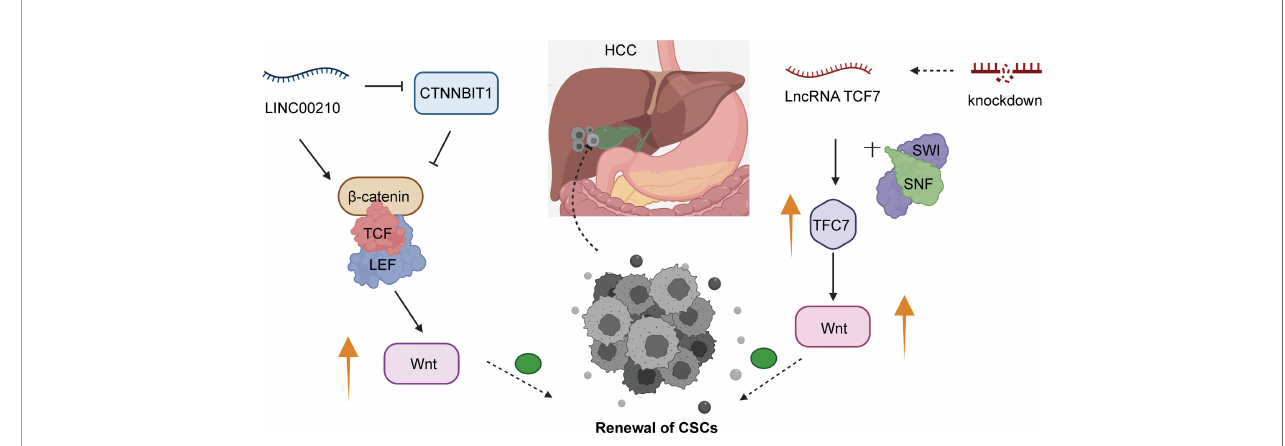
FIGURE 2 | The speci fi c mechanism of lncRNAs and the Wnt/ b -catenin pathway in the development of HCC CSCs. Overexpression of linc00210 promotes the expression of b -catenin and the TCF/LEF complex to activate the Wnt/ b -catenin pathway. lncTCF7 downregulation could impair the self-renewal ability of TICs in